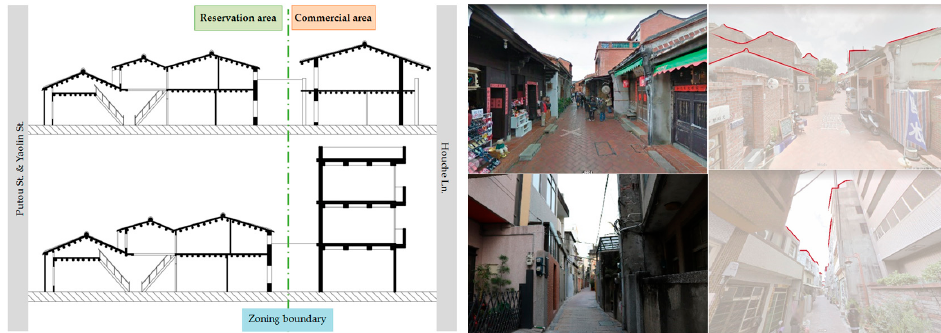
Figure 4. The section before and after zoning reconfiguration ( left ); the different space and the roof configuration of spaces on both ends of the block ( right , top , and bottom ).